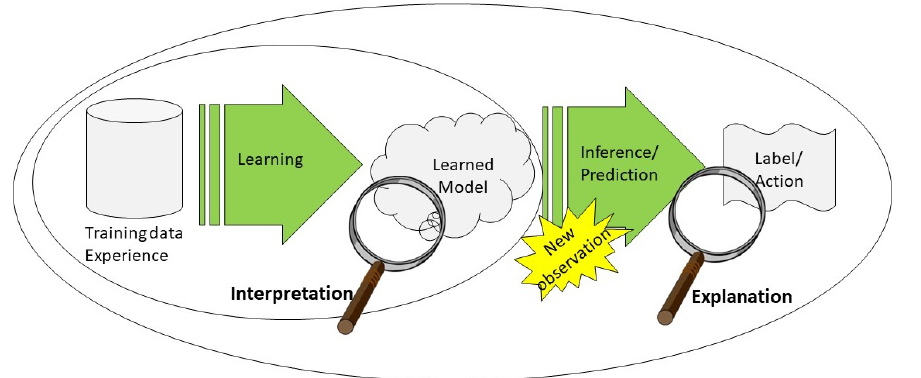
Figure 1. Interpretability of a model vs. explainability of a